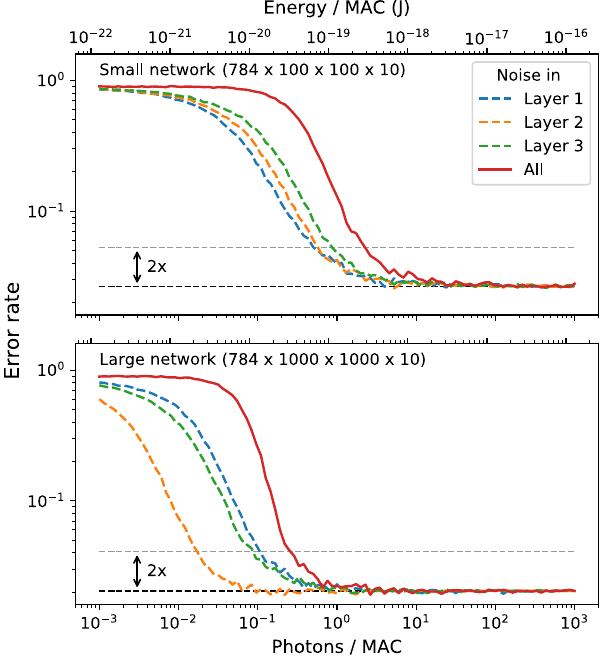
FIG. 2. (a) Illustration of a three-layer neural network with full connectivity. (b) MNIST image classified by network (size 784 → 1000 → 1000 → 10 ).